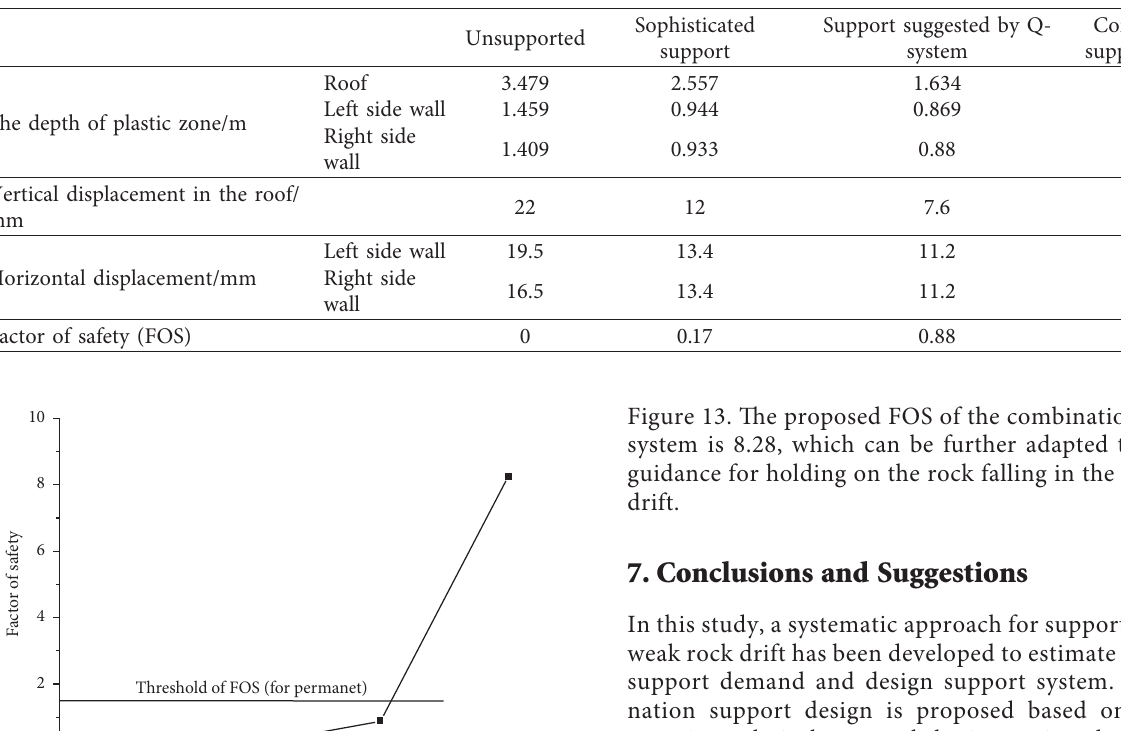
Table 7: Depth of plastic zone, displacement, and FOS of different support design obtained from